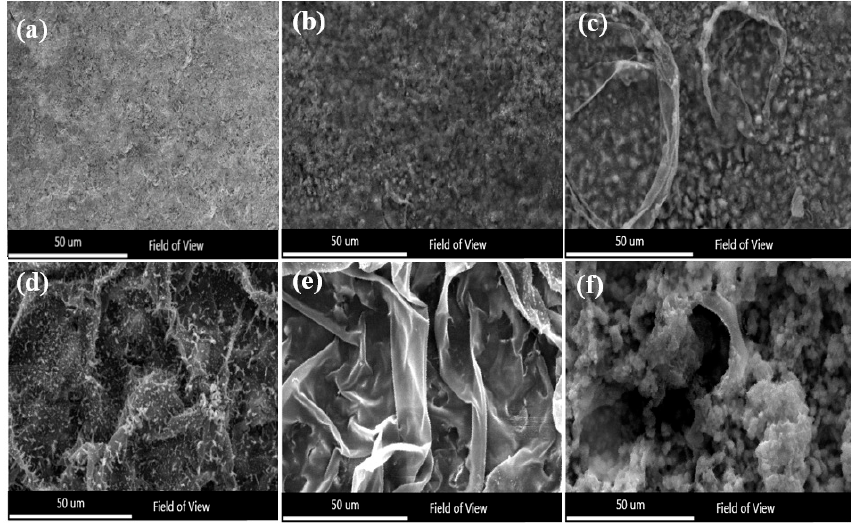
Figure 8. SEM images of pitting formed on the samples (heated 650 °C) after test: ( a ) as-sprayed coating, ( b ) 3.5% NaCl, 30 °C, ( c ) 3.5% NaCl, 40 °C, ( d ) 3.5% NaCl, 50 °C, ( e ) 3.5% NaCl, 60 °C, ( f ) 3.5% NaCl, 70 °C.